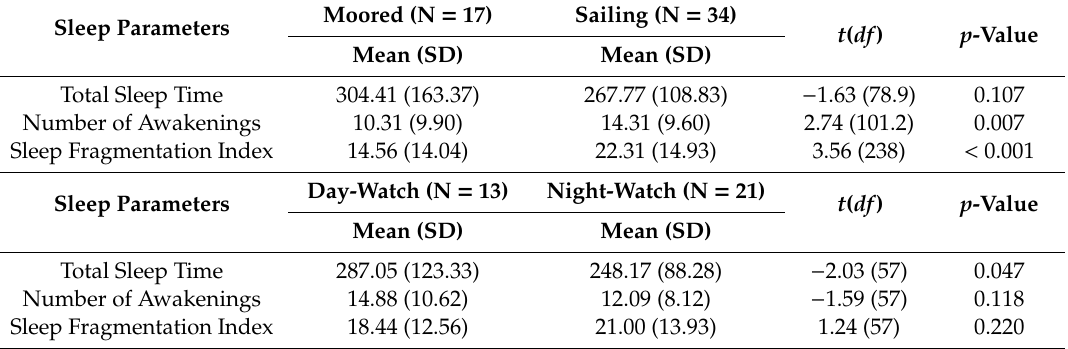
Table 3. The comparison of sleep time between harbor and sea and between day-watch and night-watch (N =